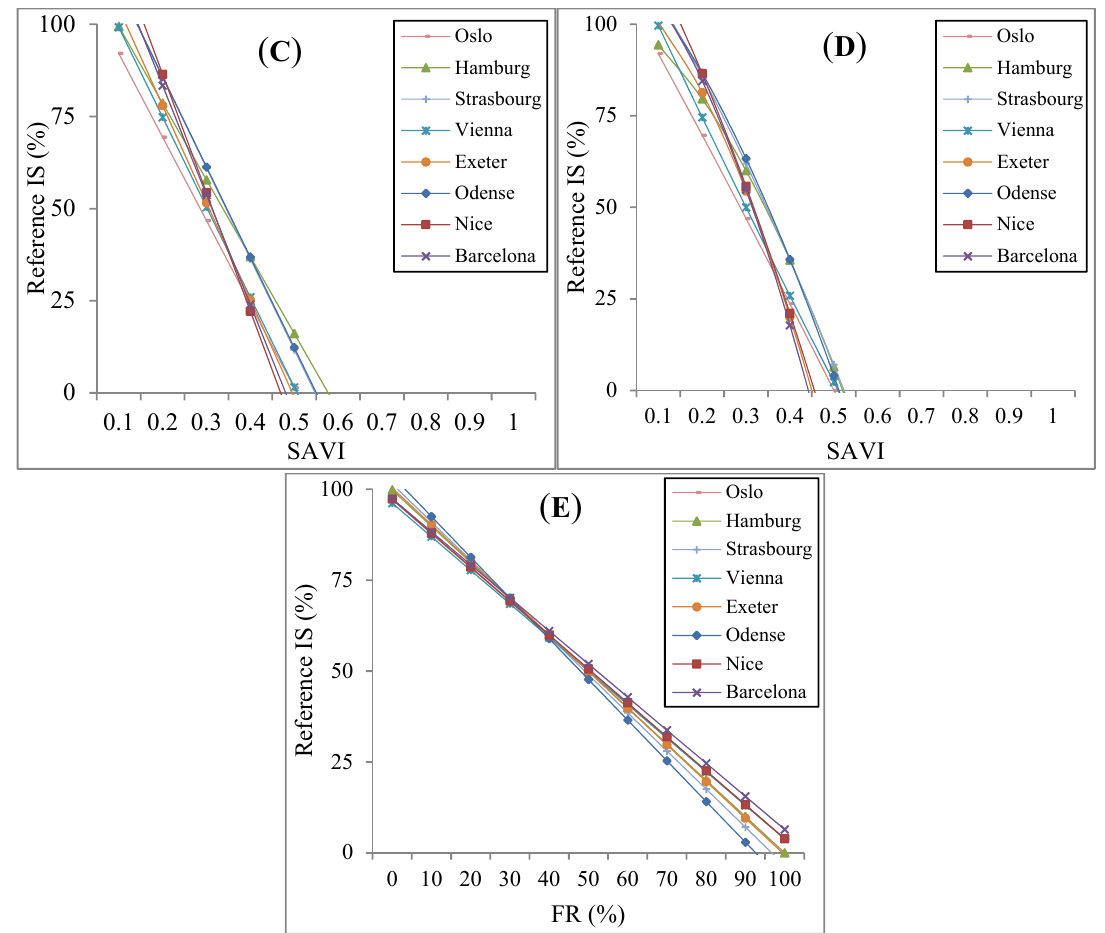
Figure 5. ( A ) Linear and ( B ) second order polynomial regression lines between reference IS fractions and NDVI, and ( C ) linear and ( D ) second order polynomial regression lines between reference IS fractions and SAVI, and ( E ) linear regression lines between reference IS fractions and